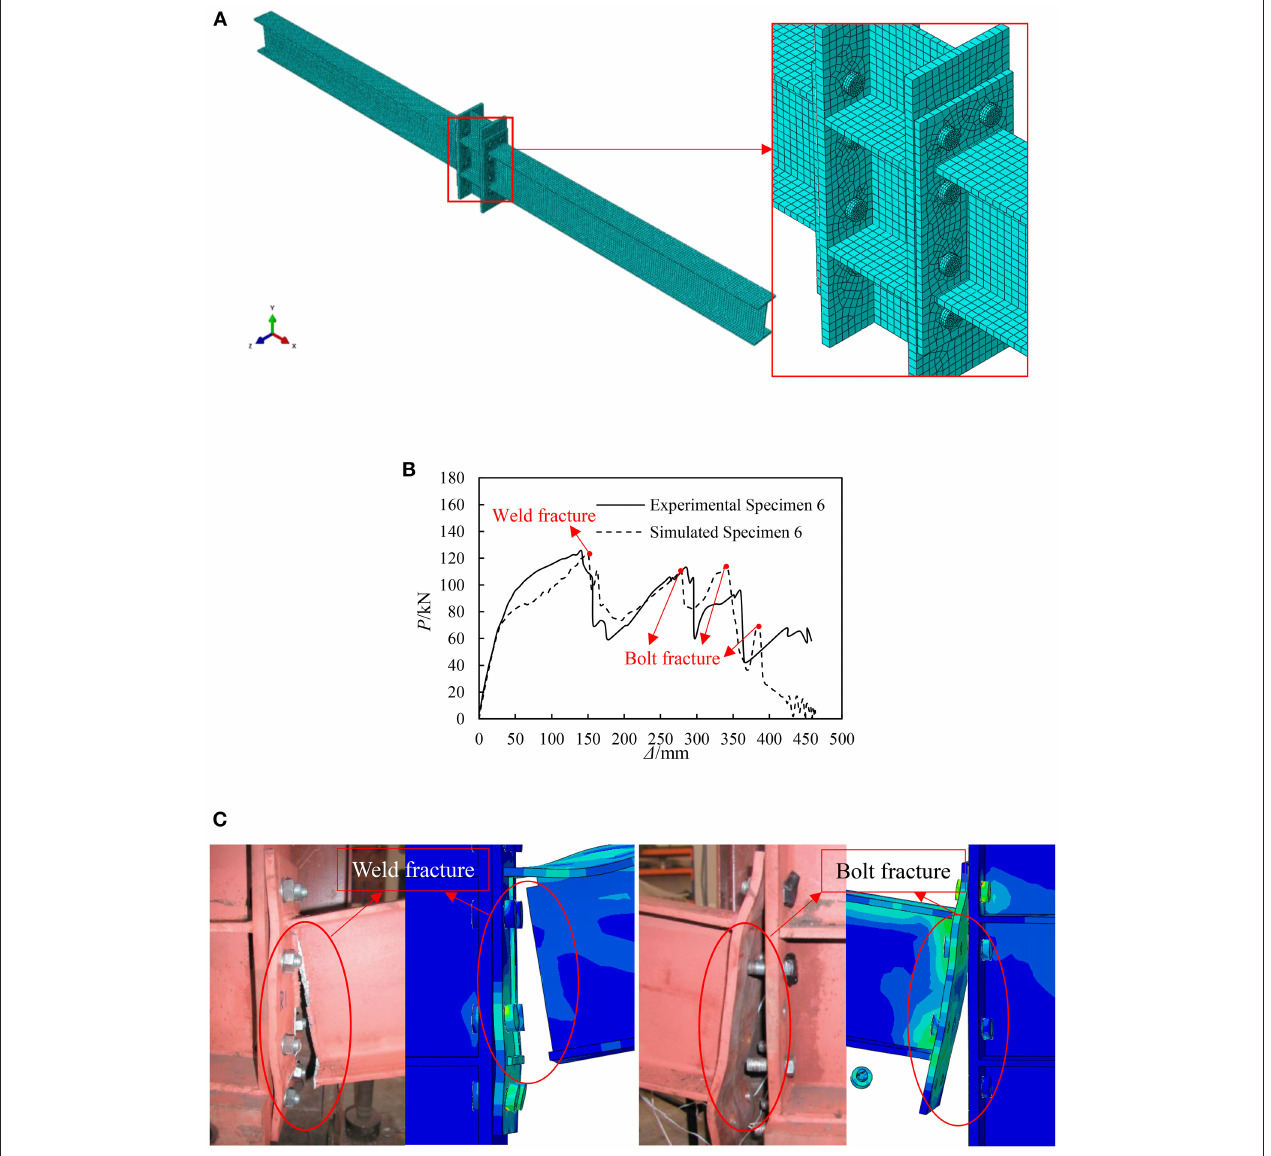
FIGURE 5 | Comparison of simulated and experimental Specimen 6. (A) FE model of Specimen 6. (B) Load-displacement at the top of column curve comparison. (C) Failure mode comparison.